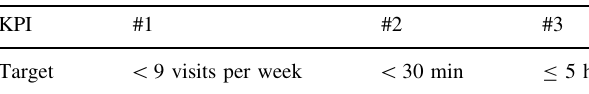
Time needed to investigate and diagnose and then generate reports relating to an operation